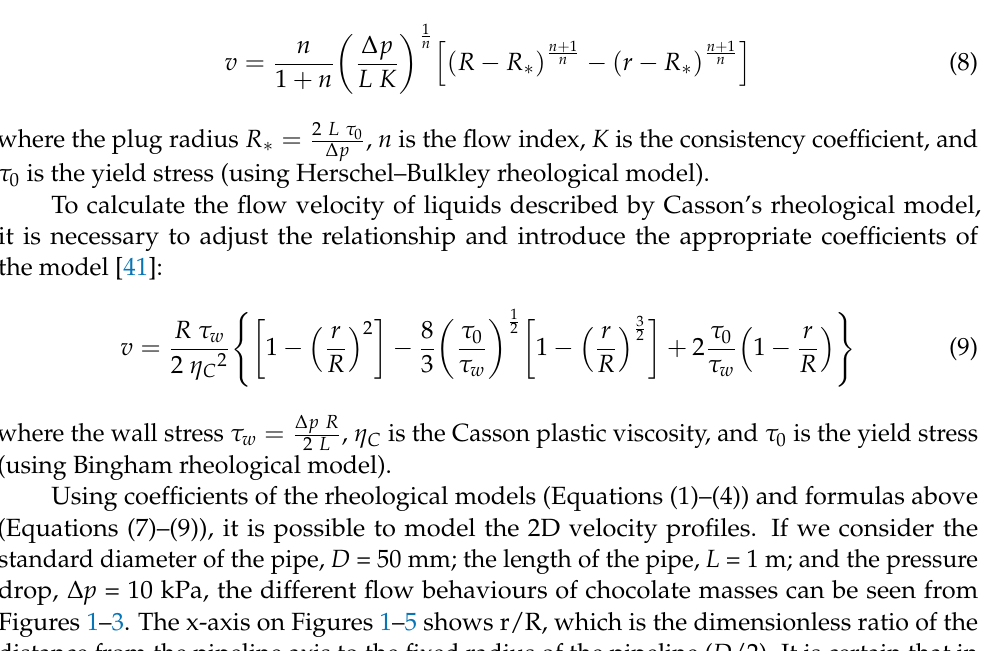
Figure 1 models the EDC sample flow velocity using all three rheology models (1) –